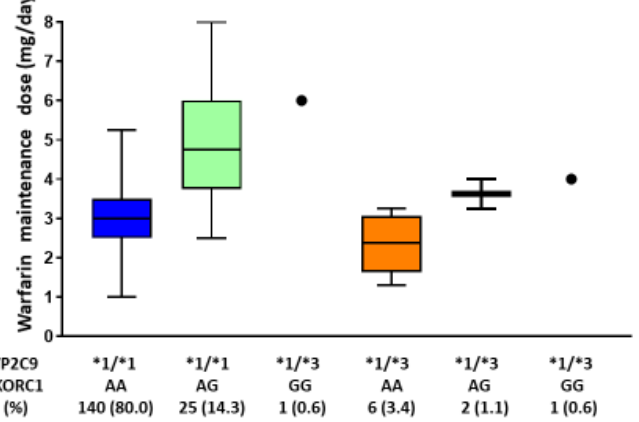
Figure 1. Warfarin maintenance dose stratified by CYP2C9 and VKORC1 genotypes. Warfarin maintenance dose was determined as the dose required to maintain PT-INR values within the target therapeutic range (1.6–2.6) during the follow-up period. In box-and-whisker plots, the central horizontal bars indicate the median values, and the lower and upper boundaries show the 25th and 75th percentiles, respectively. PT-INR, the prothrombin time-international normalized ratio.